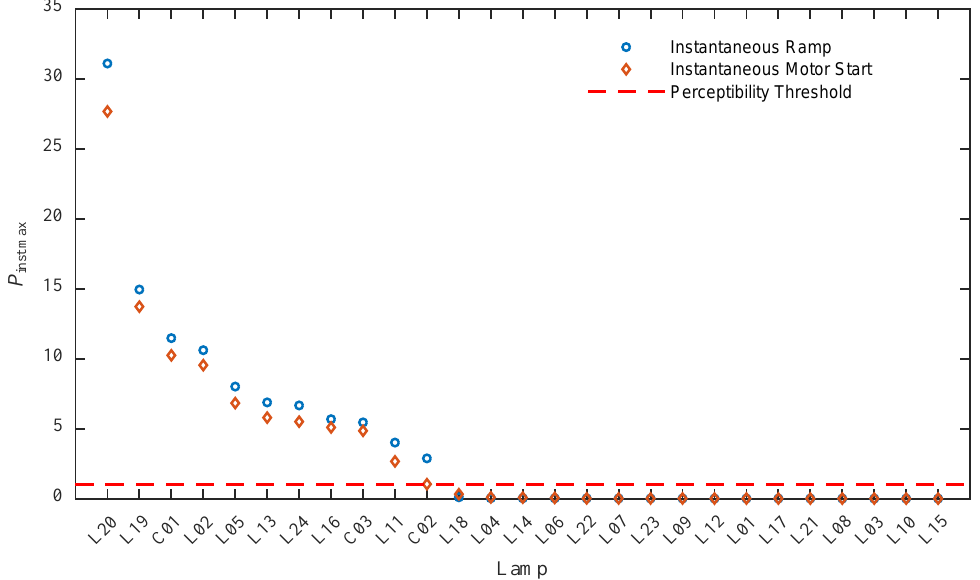
Figure 9. P instmax produced by every lamp when subjected to an RVC of 5% amplitude.